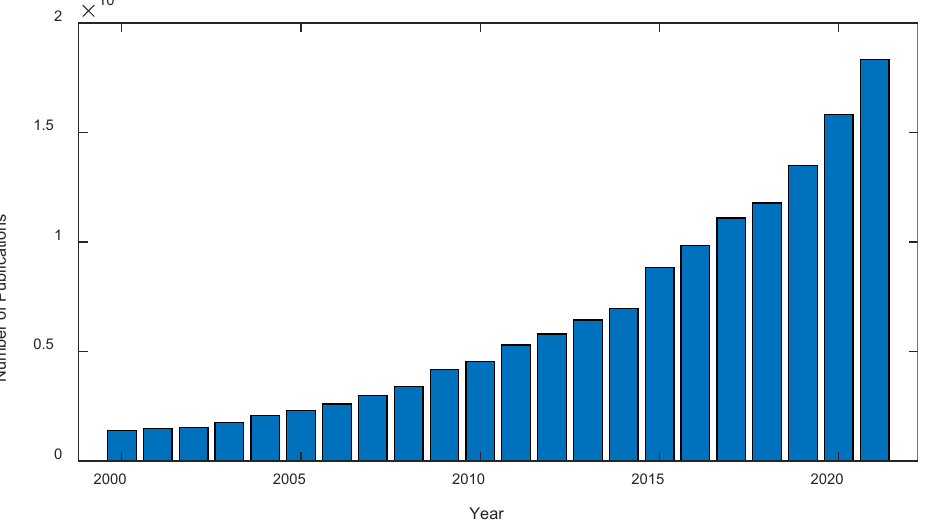
Figure 1. The number of MBD-related publications per year .